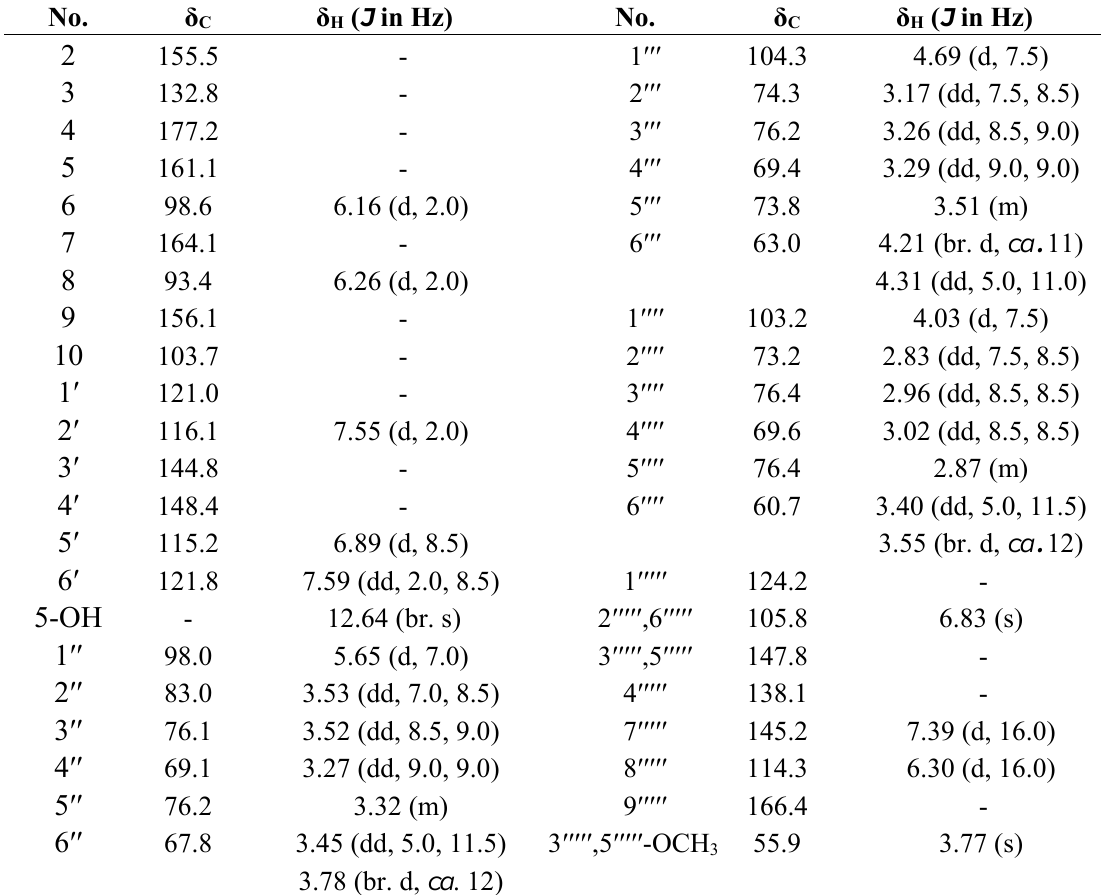
Table 2. 1 H and 13 C-NMR data for 2 in DMSO- d 6 (500 MHz for 1 H and 125 MHz for 13